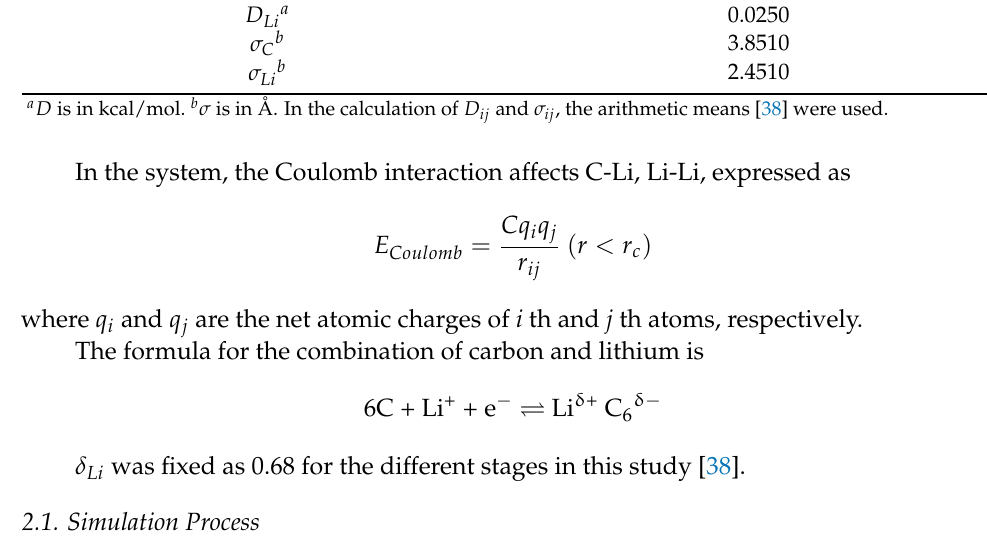
Table 1. Potential energy parameters. Parameter Value D Ca